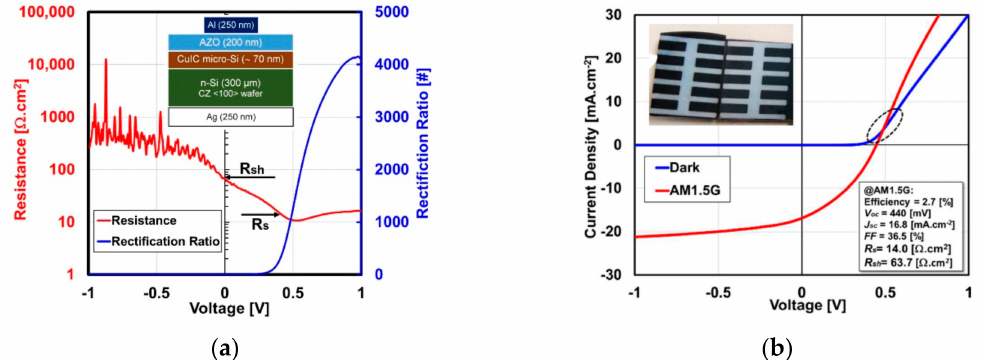
Figure 11. ( a ): the p-n junction rectification ratio and cell dynamic resistance, ( b ) the J-V curve of the best sample of a micro-Si solar cell fabricated by MS and CuIC. The structure of the designed solar cell and two fabricated samples are shown in the inset